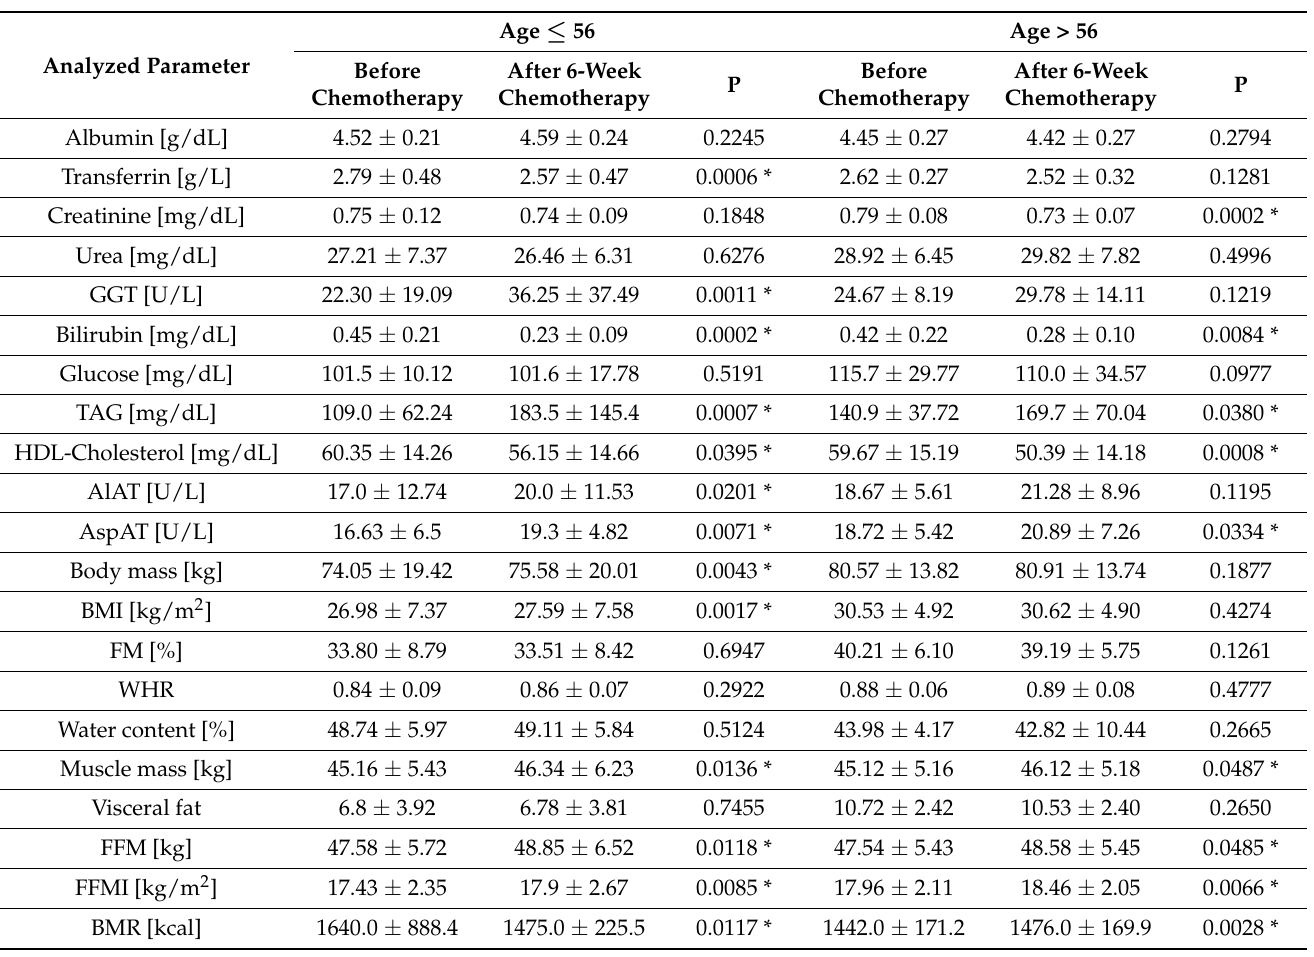
Table 7. The influence of age on body composition and biochemical parameters in the matched supplemented group after six weeks of chemotherapy.